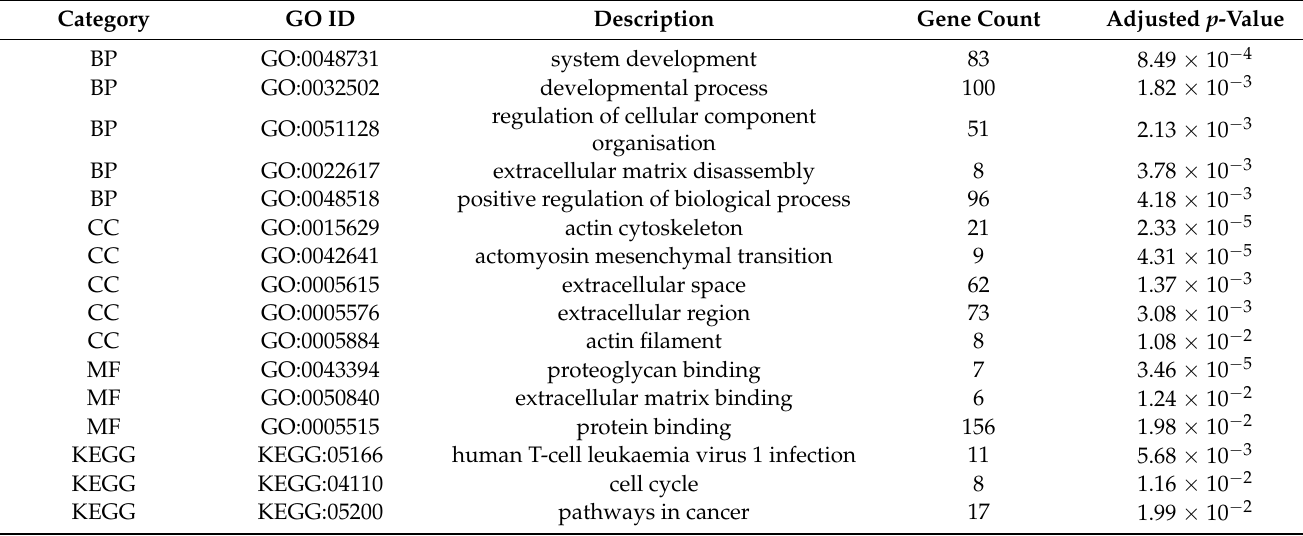
Figure 4. GO enrichment and KEGG pathway enrichment analysis. In the vertical direction, the higher the bubbles, the more significantly enriched. In the horizontal direction, terms from the same GO subtree are located closer to each other. Bubbles’ size stands for term size (gene quantity contained). The X-axis represents the group of functional terms and coloured by data sources, and the Y-axis lays out the adjusted p -value on the negative log10 scale. Table 1. List of top 5 significantly enriched GO terms and KEGG pathways of DEGs.